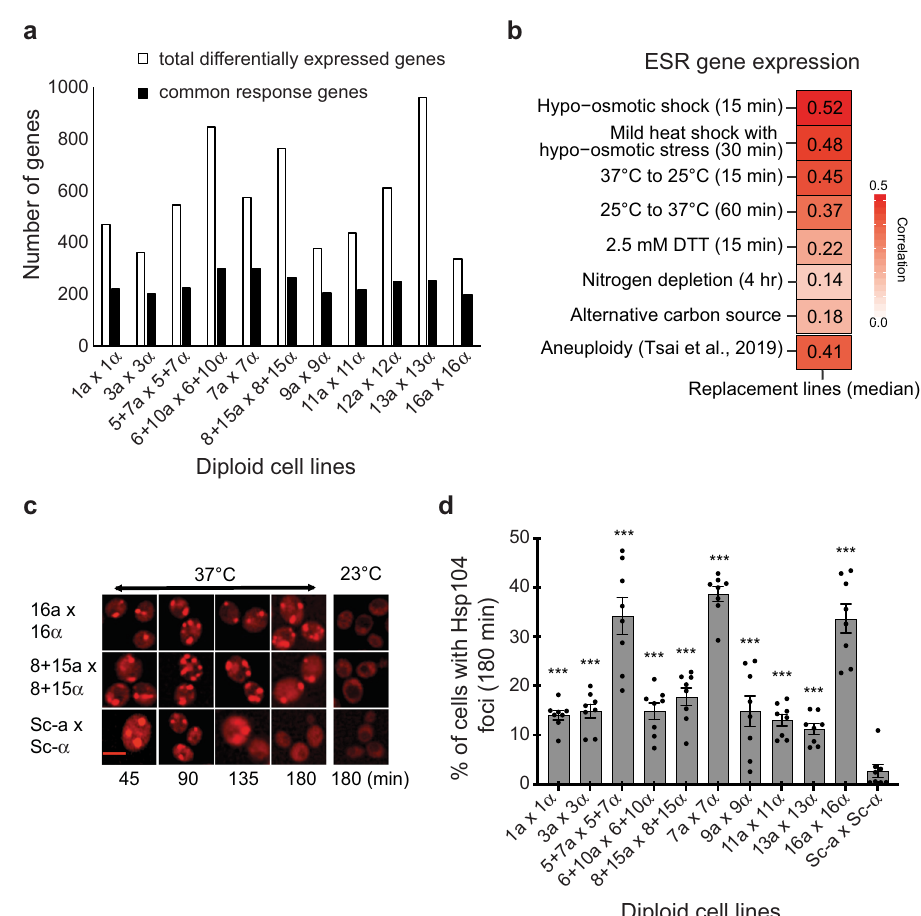
Fig. 1 | Foreignchromosomesinduceproteotoxic stress in diploidhybrid cells. a Hundreds of genes are differentially expressed in diploid chromosome replace- ment lines. The replacement lines were cultured in rich medium at 23°C and their transcriptomes were examined using RNA-seq. A gene was classi fi ed as differen- tially expressed if the fold-change of a replacement line gene to its parental S. cerevisiae strain wasgreater than1.5 with anadjusted p -value < 0.05. The genes on the replaced chromosomes were excluded from the analysis. Common-response genes refer to the genes commonly up- or downregulated in at least four replace- ment lines. A complete gene list can be found in Supplementary Data 1. b The expressionpro fi leofdiploidreplacementlinesispositivelycorrelatedwiththoseof wild-typecellsunderstressconditionsandaneuploidcells.Themedianexpression levels in eleven diploid replacement lines were compared to the environmental stress response (ESR) dataset 33 and the aneuploid transcriptome 42 . Spearman ’ s correlation coef fi cients were calculated and are shown in the fi gure. Details